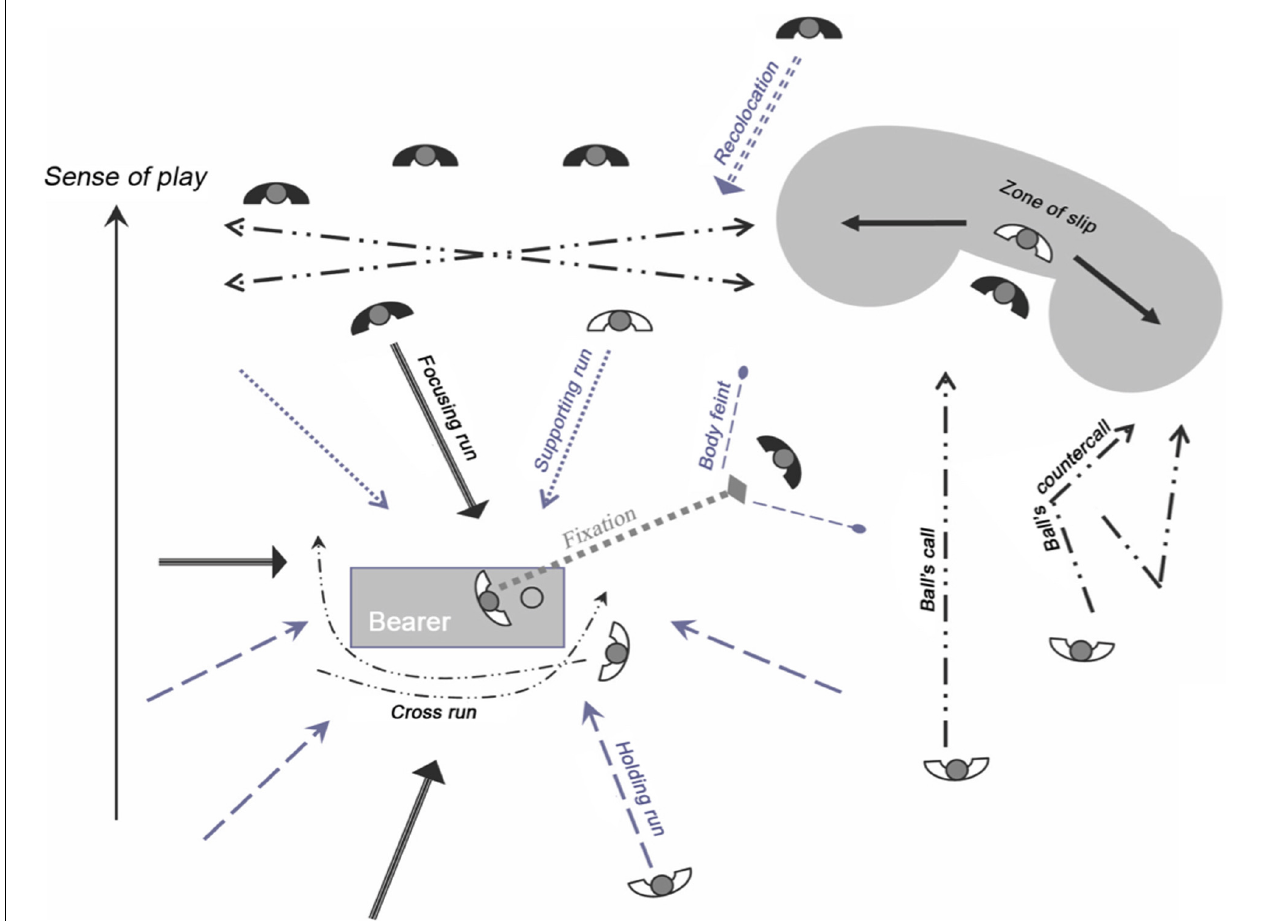
FIGURE 1 | The main praxemes mobilized by footballers during the course of the game. Four praxemes do not appear on the diagram. (i) “Returning run,” which is the driving action of a player who returns to his side after his team loses the ball; (ii) “Tracking run,” which is the driving action of a player who returns to his side by following an opposing player after the loss of the ball by his team; (iii) “Shooting feint”; (iv) “Passing feint.”